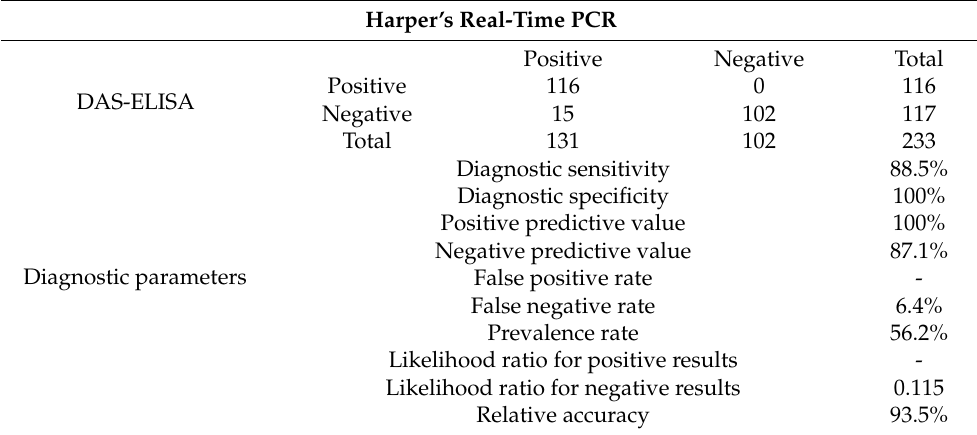
Table 4. Contingency table comparing mAb2G1/PPD DAS ELISA with real-time PCR Harper et al. [31] for Xylella fastidiosa detection in samples of naturally infected and healthy plants. The upper part shows the positive and negative results for each technique. The diagnostic parameters corresponding to these results are shown in the lower part.